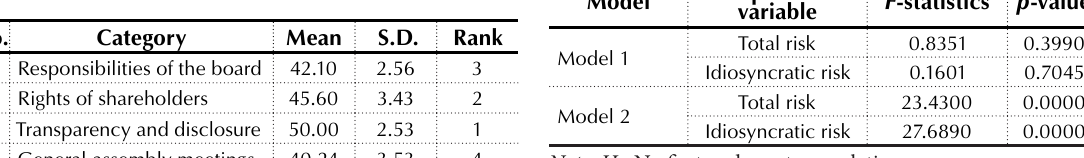
Table 3. Descriptive statistics of sub-CGI